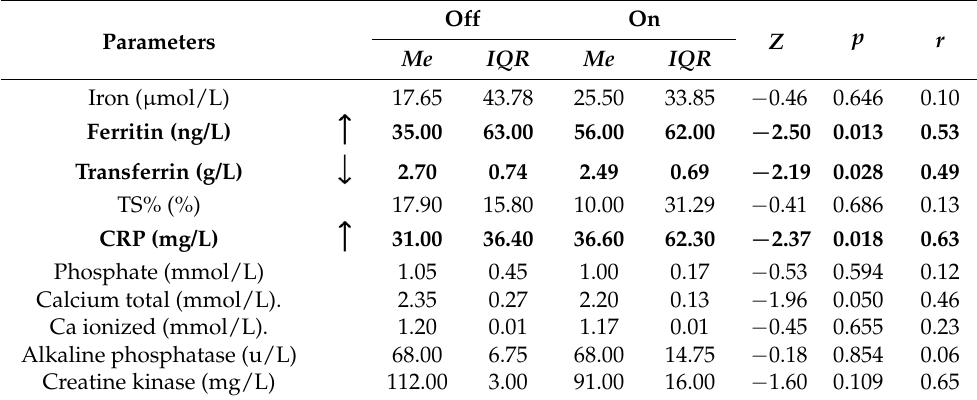
Table 1. Comparison of selected biochemical parameters before and after electrical stimulation in DBS and SCS groups. Parameters in bold were significantly different. Trend arrows show the change of examined parameters.